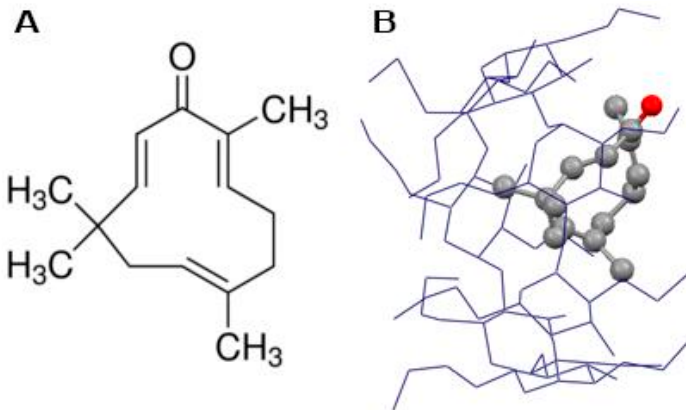
Figure 1. Chemical structure of zerumbone ( A ) and zerumbone encapsulated in hydroxypropyl- β - cyclodextrin (ZER -HP β CD) ( B ) . hydroxypropyl- β -cyclodextrin (ZER -HP β CD) ( B